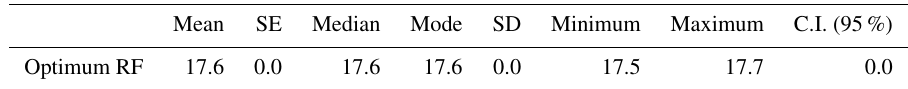
Table B4. Descriptive statistics of MSR for the optimum selected RF model, after 30 iterations with 80% of the sample as training data, ntree = 600, and mtry =